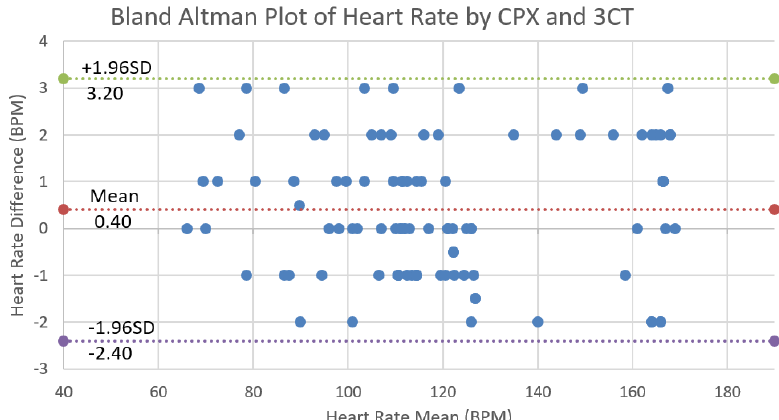
Figure 5. Bland–Altman plot for 99 heart rate data pairs of three subjects measured by cardiopulmonary exercise testing (CPET) and 3CT, with the representation of bias 0.40 and limits of agreement (dotted line) from − 1.96SD ( − 2.40) to 1.96SD (3.20). Here, three subjects are empirically picked up and